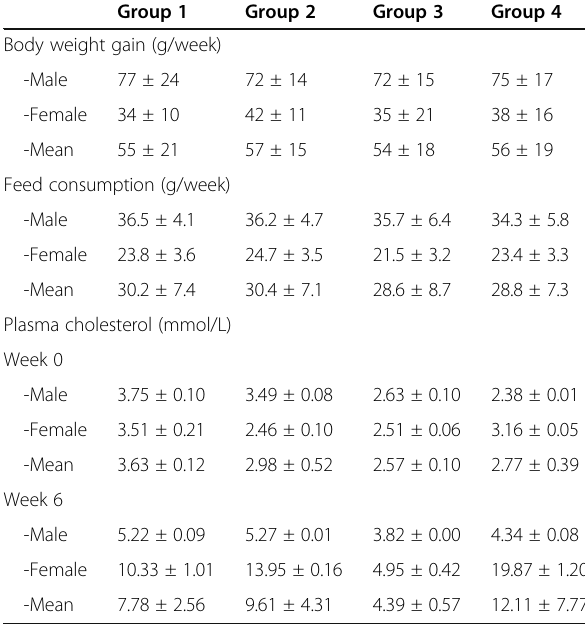
Table 2 Effect of experimental diets on feed consumption, body weight and plasma cholesterol levels in rats fed cholesterol-enriched diets